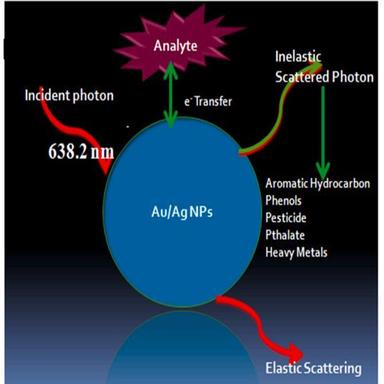
Detection Mechanism of analyte using Au/Ag-NPs.